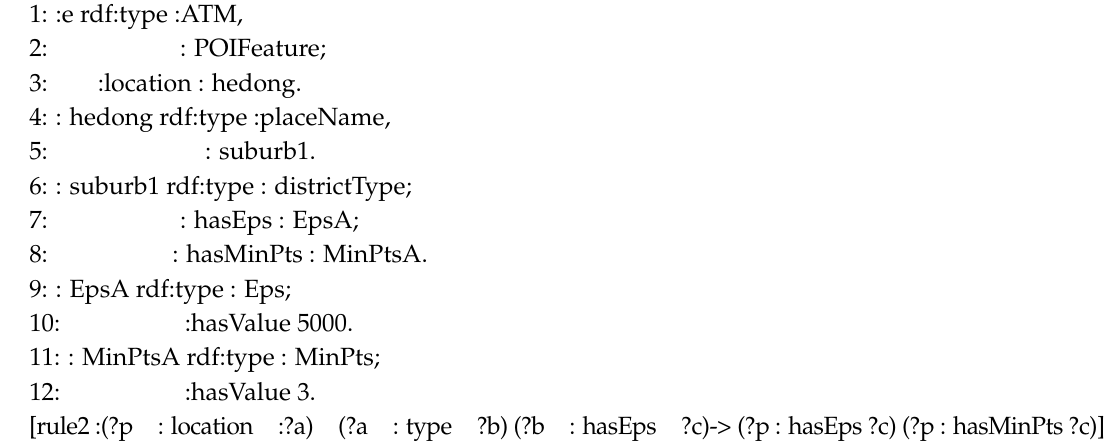
Algorithm 2. Definitions of Point e and Appropriate Values for Eps and MinPts.